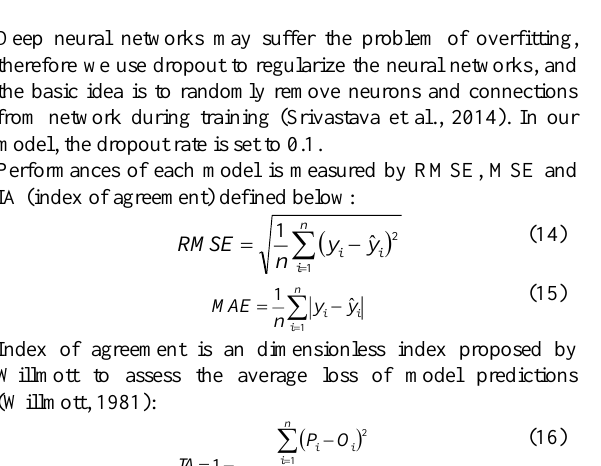
Table 5. Training details of deep neural networks